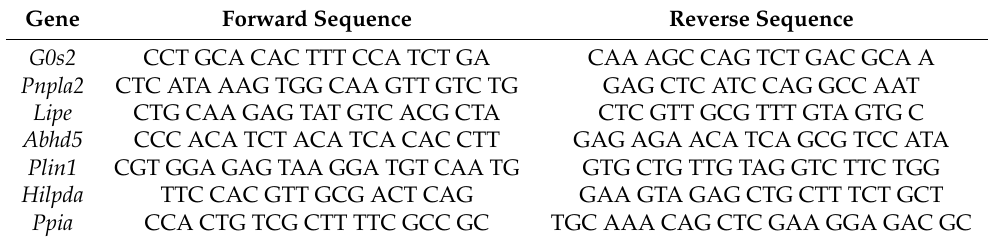
Table 2. Primers used for